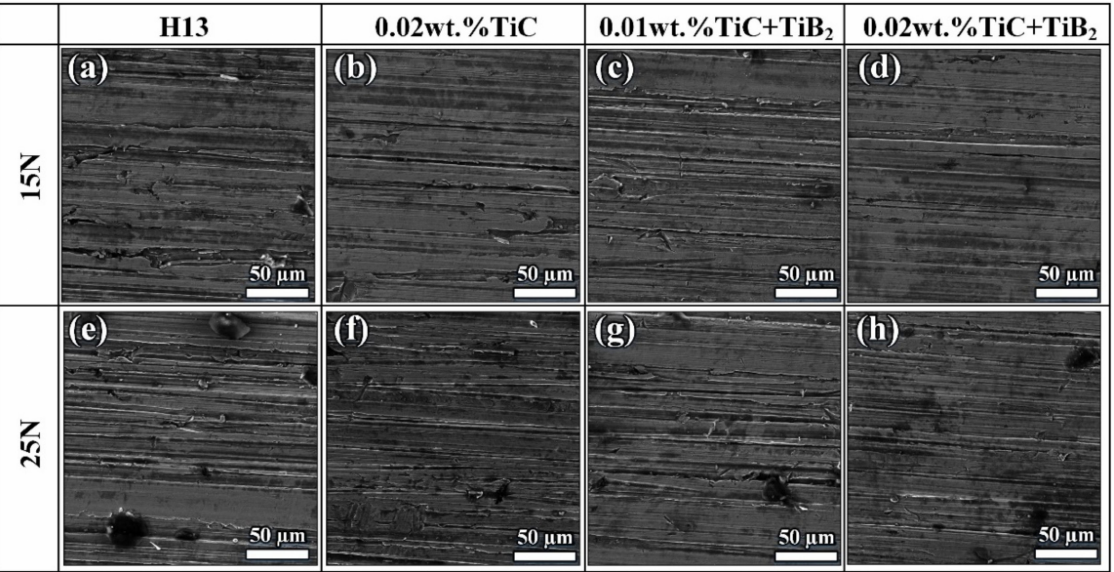
Figure 7. SEM of worn surface of H13 steels without and with nanoparticles under sandpaper with abrasive particle size of 28 µ m and different loads: ( a – d ) 15N and ( e – h ) 25